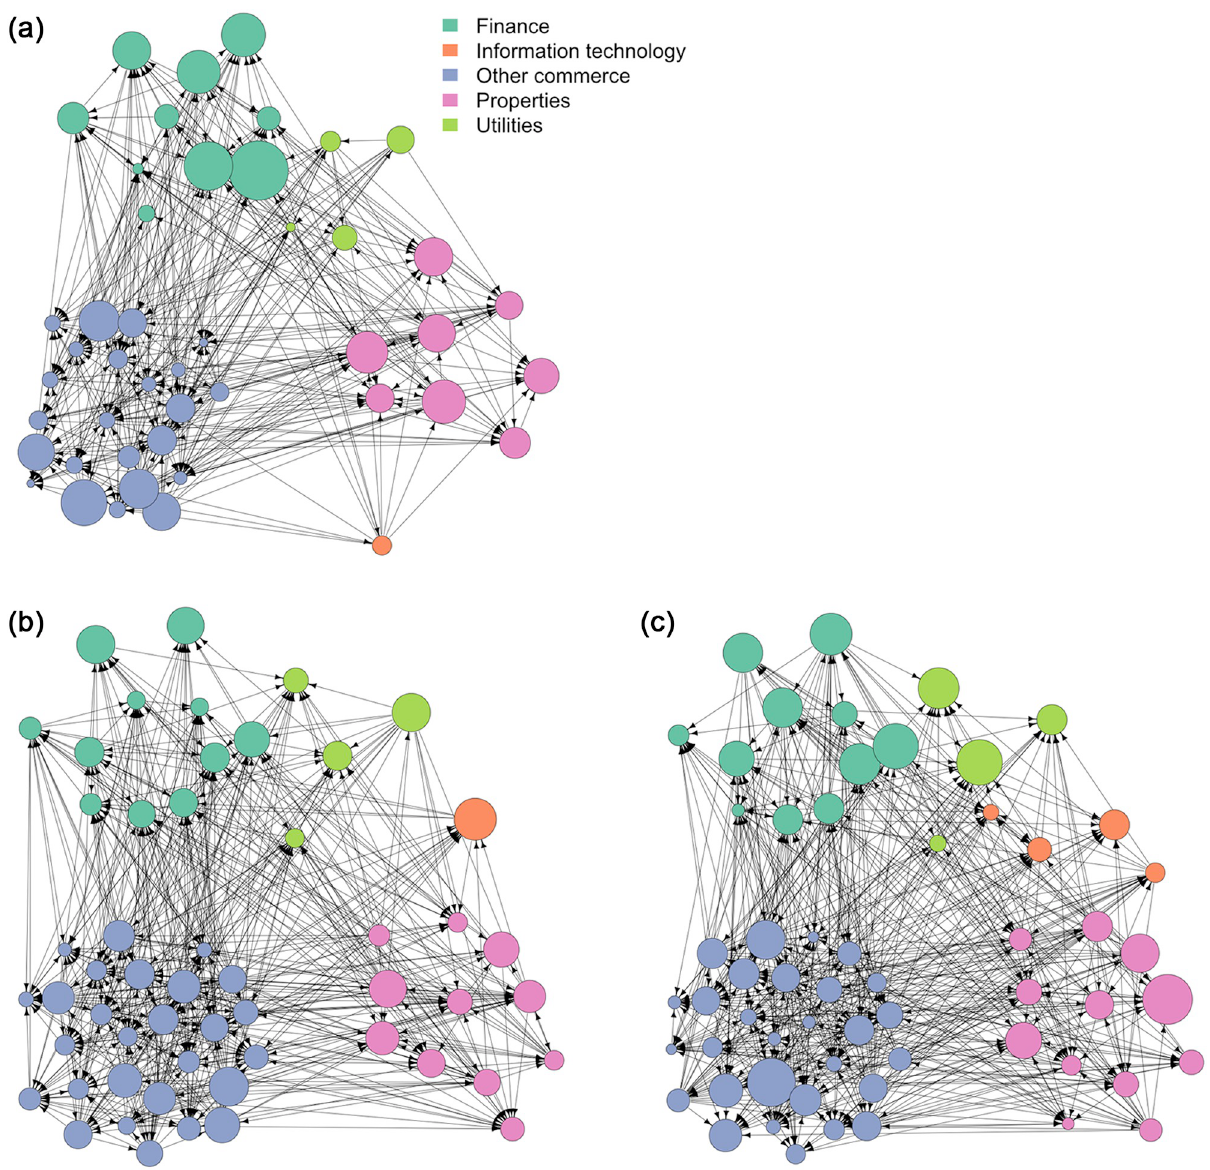
Fig 6. Visualization of the networks on three selected days. The black arrows represent edges and the circles represent nodes. The nodes are coloured by their sectors, and the sizes of the nodes are proportional to the 60-day moving average of the relative topological orders calculated using Eq (5). a) Visualization of the network on 27 October 2008 (during the global financial crisis. The HSI was at its lowest price on this day in 2008). (b) Visualization of the network on 26 January 2018. The HSI was at its highest price ever. c) Visualization of the network on 23 March 2020 (during the COVID-19). The HSI was at its lowest price on this day in